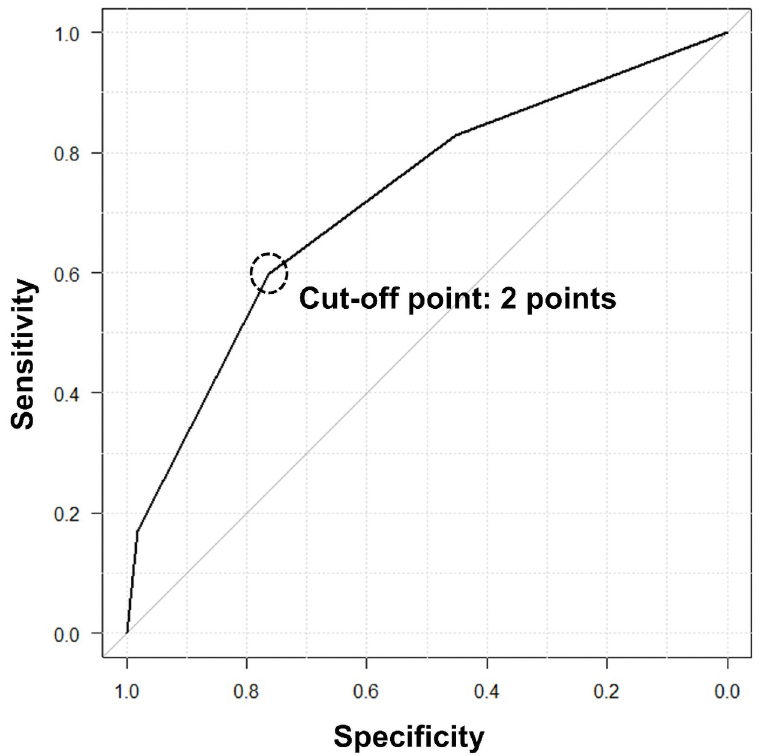
Fig 2. The ROC of the predictive score for the identification of ch ū niby ō . The score included the following three variables: Thinking that academic tests were not enough to measure their true abilities, feeling that something was wrong with the world, and having any imaginary/fantasy friends or boyfriends/girlfriends. Each variable was assigned a value of 1 point; thus, the maximum total score was 3 points. The AUC was 0.721 (95%Cl 0.658–0.784). When the cut-off value was 2 points or more, the sensitivity, specificity, and odds ratio were 59.8%, 76.3%, and 4.75 (95% Cl 2.70–8.46), respectively. ROC: Receiver operating characteristic, AUC: The area under the receiver operating characteristic curve, Cl: Confidence